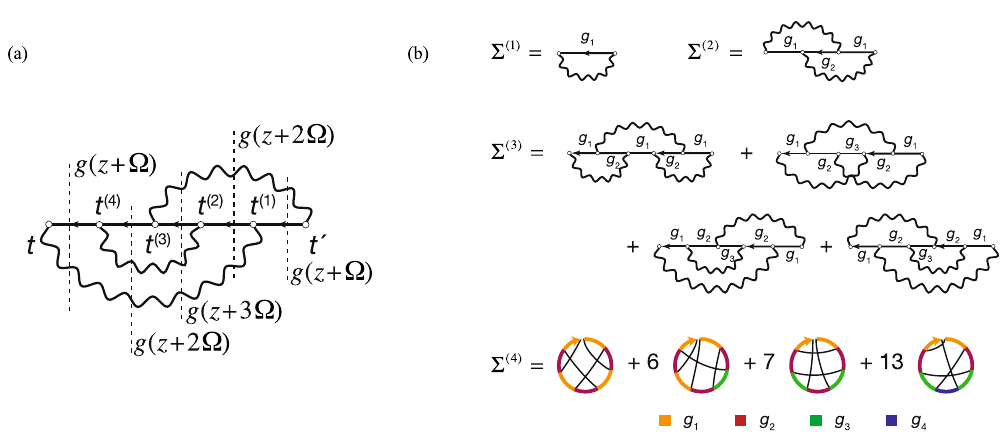
Figure 3. ( a ) Example of the self-energy in the time domain. The system contains only holes. Therefore, there is only one possible time-ordering < < . Bosonic propagators are denoted as wavy- lines. In the frequency representation the given SE diagram yields ω ) . ( b ) Four lowest orders of the SE diagrammatic expansion of the electron-boson model. Notice that two diagrams of the third-order containing loops are not shown because they are equal to zero. The fourth-order self-energy is given in terms of chord diagrams with color-coding. Only one representative for each class is shown. Due to the absence of loops, an isomorphism between the Feynman diagrams and the chord diagrams can be